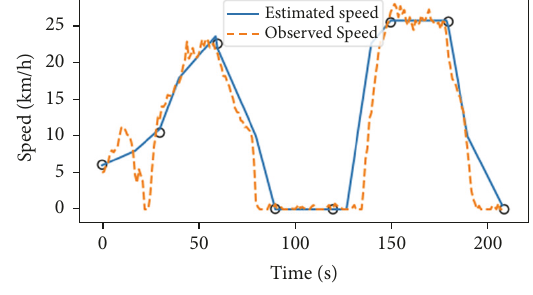
(c) Estimated and observed speed for trajectory with 7 sample points Figure 9: Estimated and observed speed for different types of trajectory.